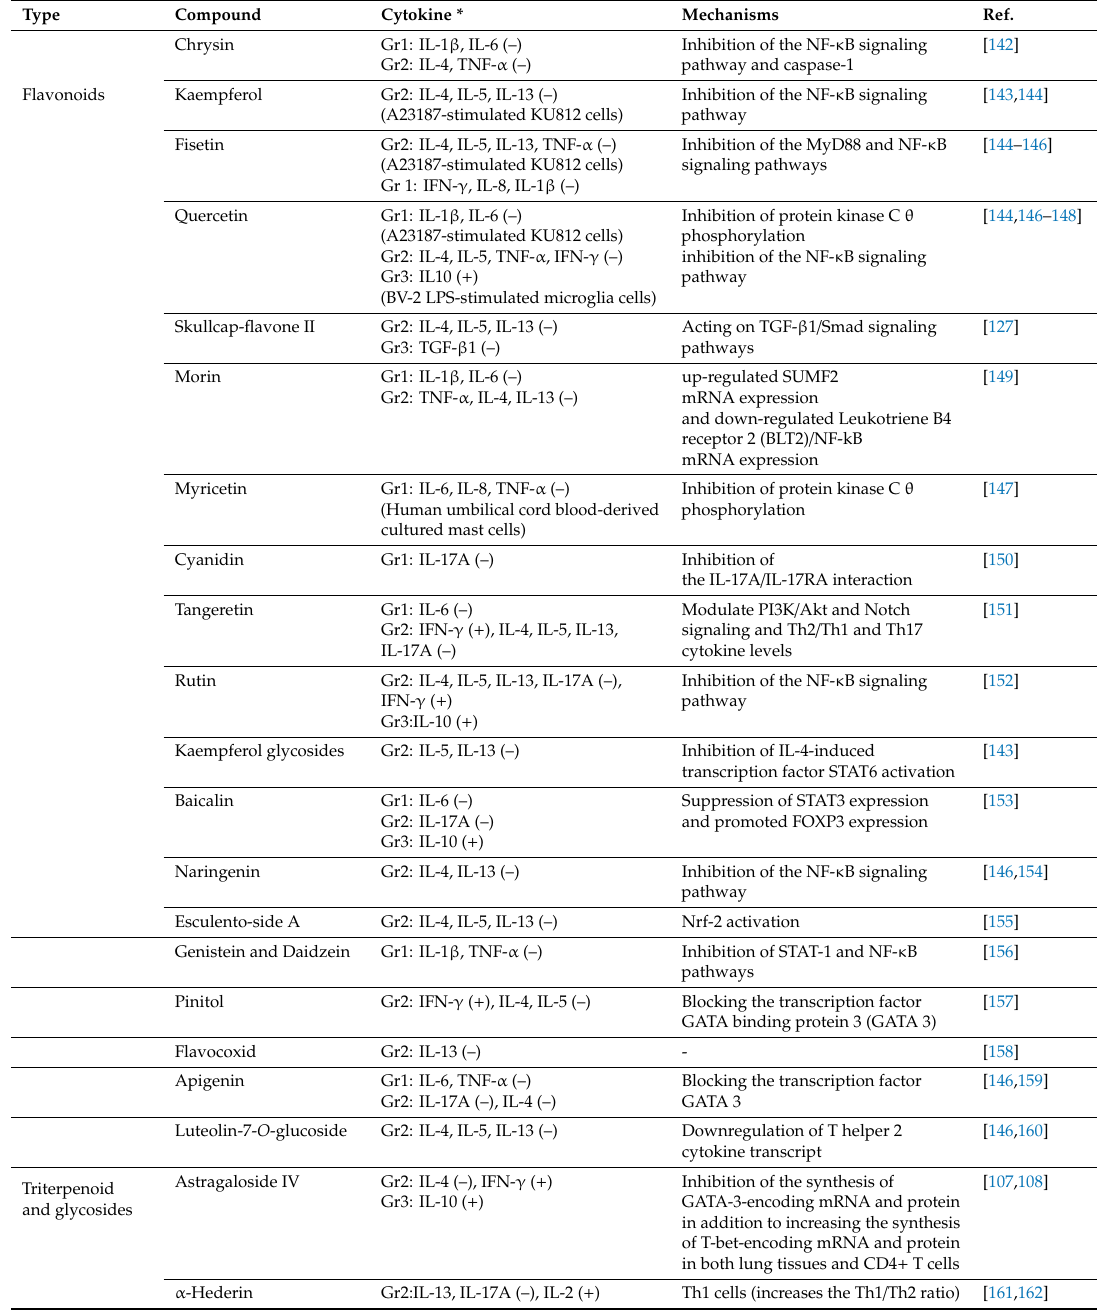
Table 3. Relationship of cytokines with the compounds. NF- κ B: nuclear factor- κ B.